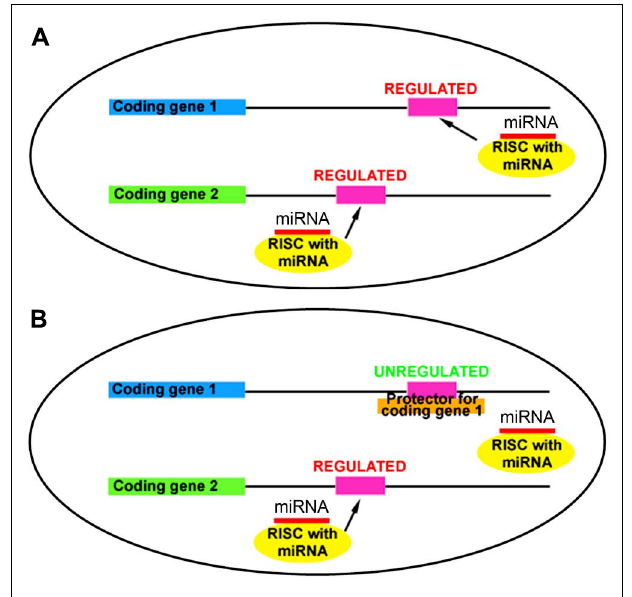
FIGURE 1 |Target protectors block miRNA action at a specific mRNA binding site. (A) miRNAs regulate multiple targets through sequence- specific binding in the 3 (cid:2) UTR. (B) Target protectors block miRNA action at a single target, while other targets remain